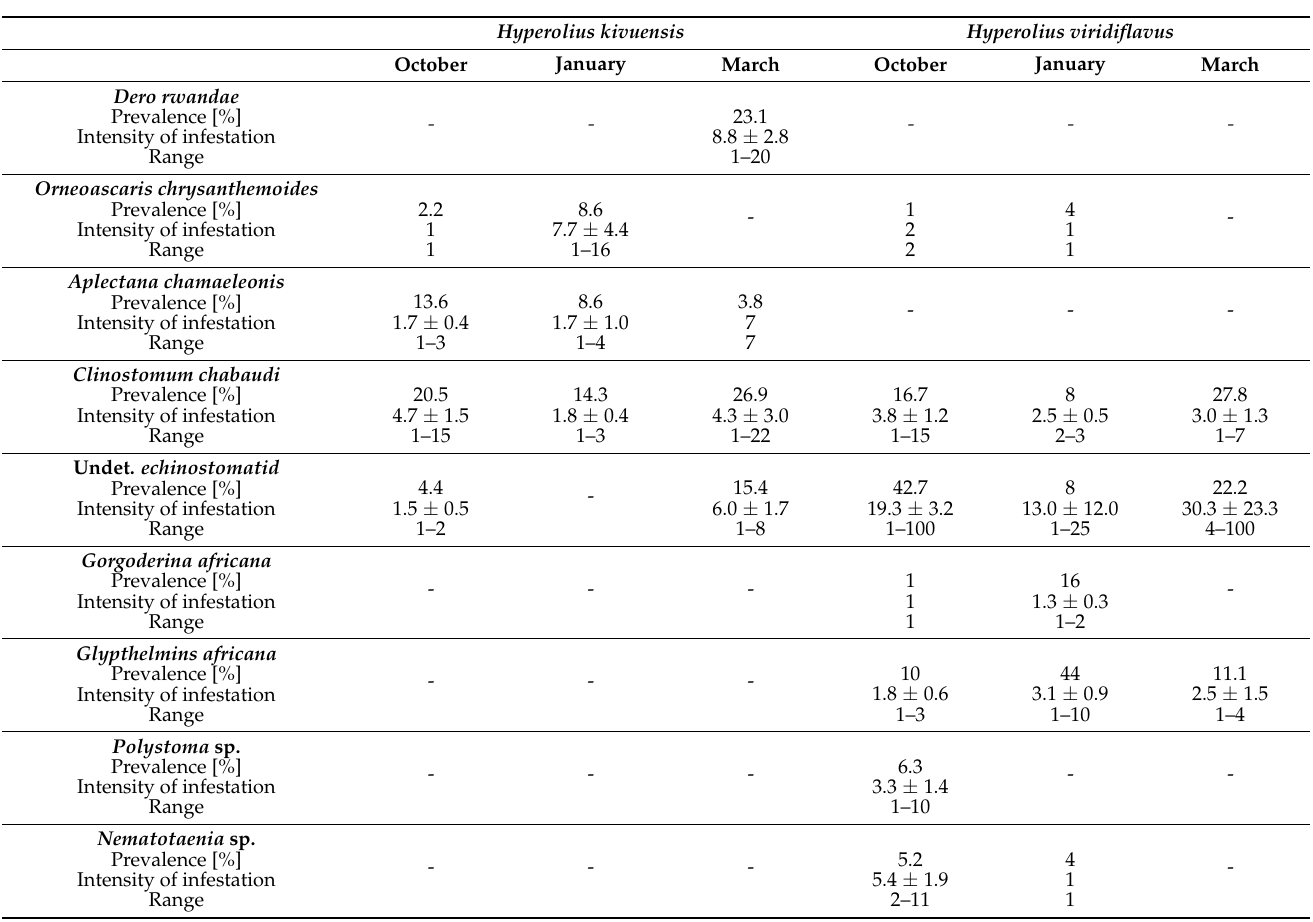
Table 4. Seasonal variation of infestation by metazoan parasites in the two host species. October marks the beginning of the rainy season, January a period of less rainfall, March the end of the rainy period. Prevalence is expressed as percent of collected individuals infested with the specific parasite. Intensity of infestation is expressed as the number of parasite individuals in a single frog host. Orneoascaris schoutedeni and Rhabdias collaris are not listed because they were found only in a single host